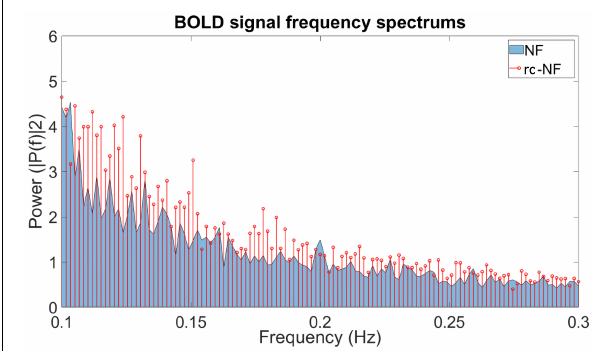
FIGURE 10 | Frequency plot showing the contribution of different frequencies in the BOLD signal from the ROI during the NF training. The NF group tends to emphasize different frequency ranges during regulation compared to the rc-NF group.